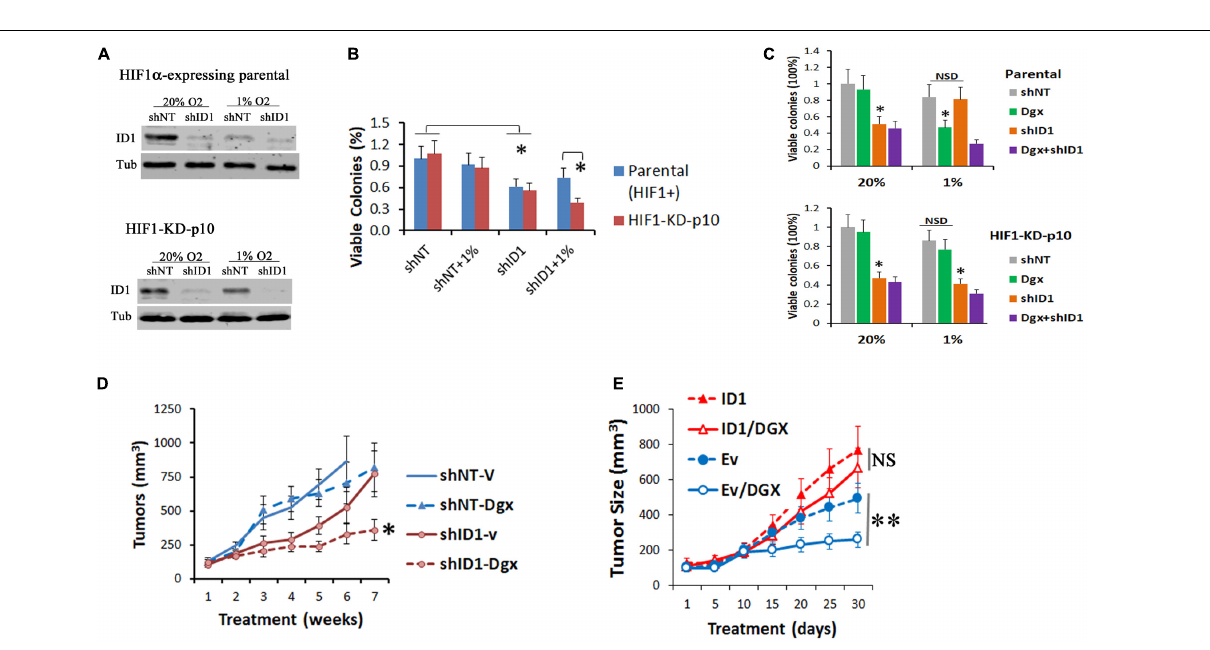
Frontiers in Cell and Developmental Biology |